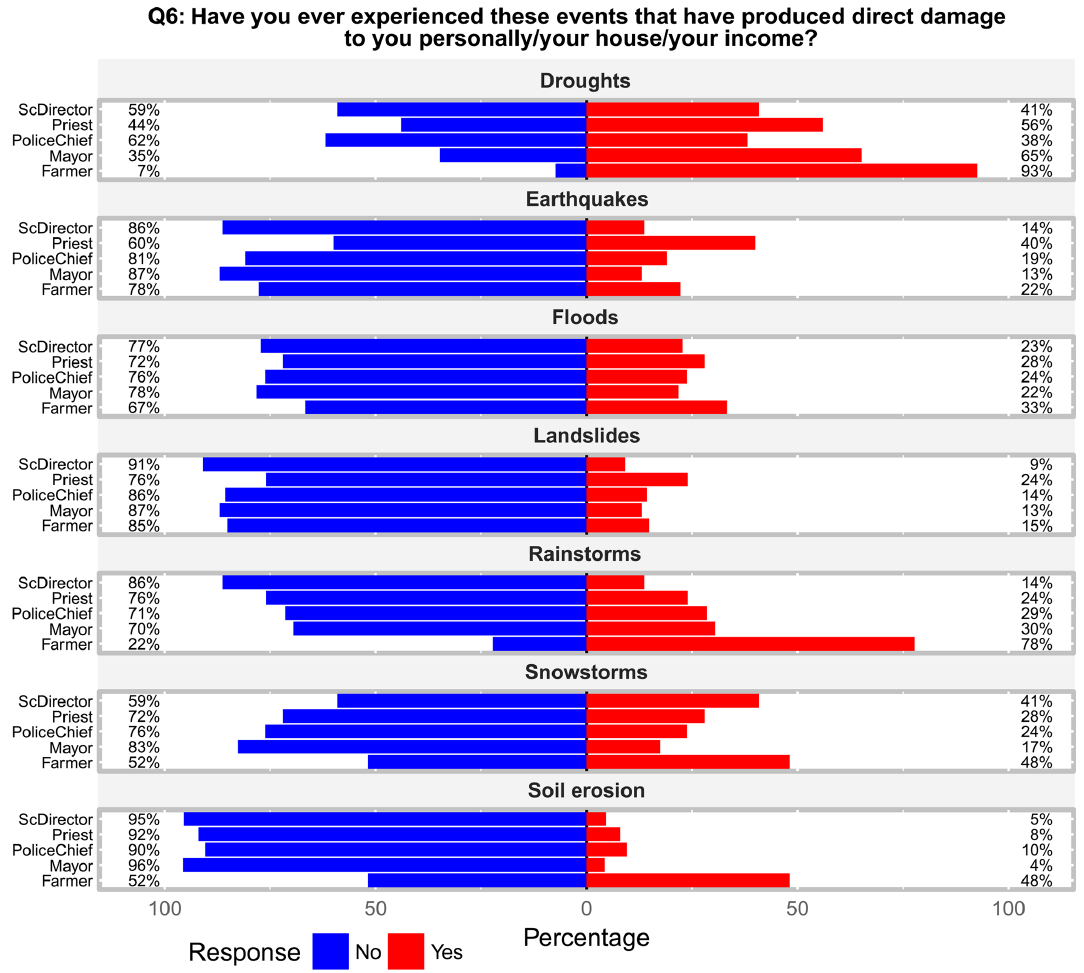
Figure 8. Stakeholders’ past experiences of natural